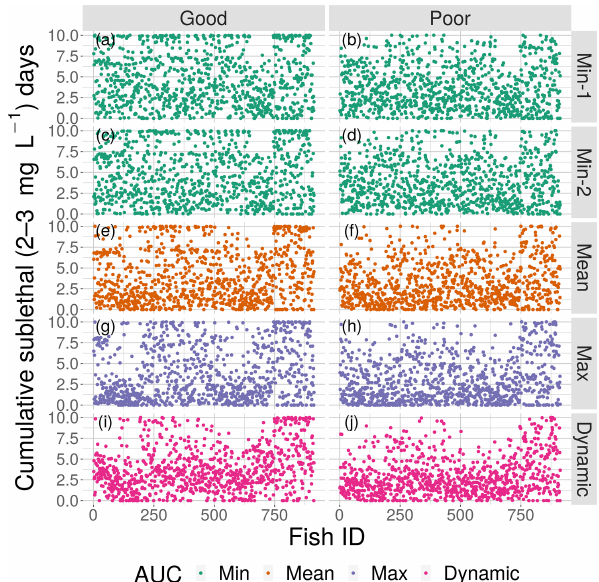
Figure 10. Cumulative exposure (days) of each individual fish to DO concentrations of 2–3mgL − 1 for good (left) and poor (right) competency for each of the four snapshot DO maps with high sub- lethal area and the dynamic version. Maps within the same AUC category (the two “Min” maps) are shown with the same